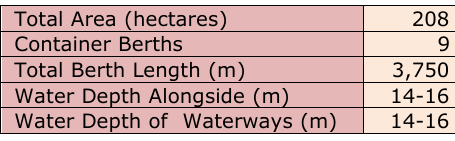
Table 1. Facts of study